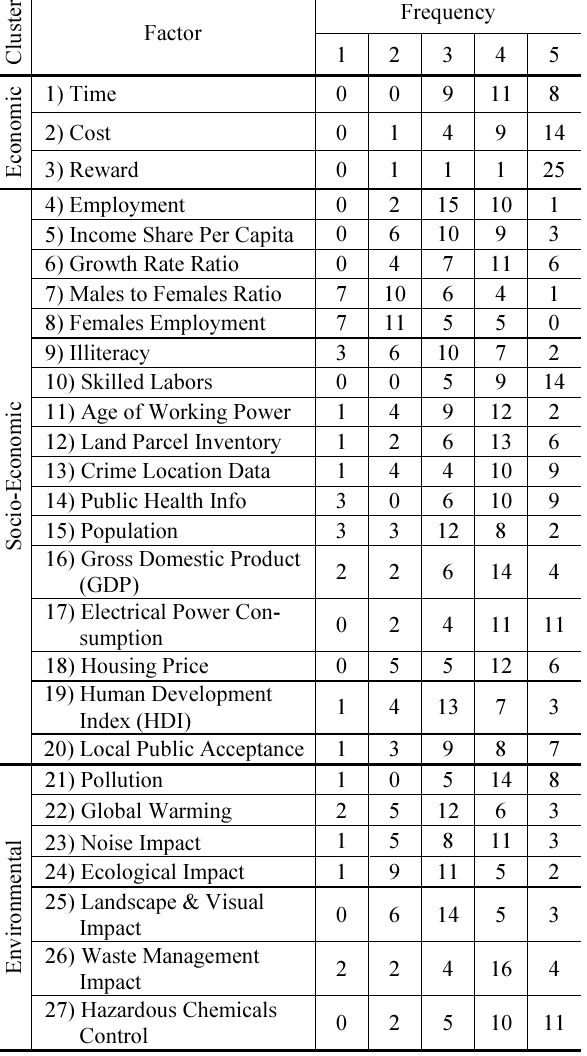
Table 1. Frequency of importance for gathered